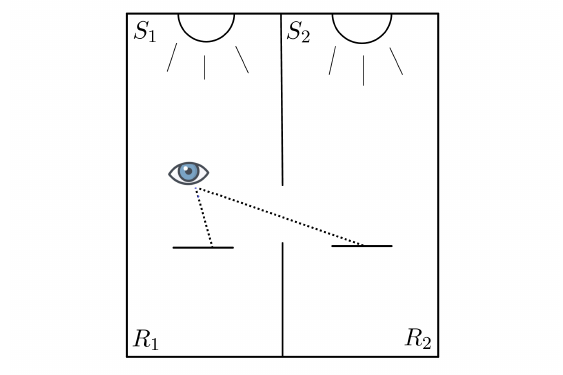
Figure 3. The experimental apparatus considered by